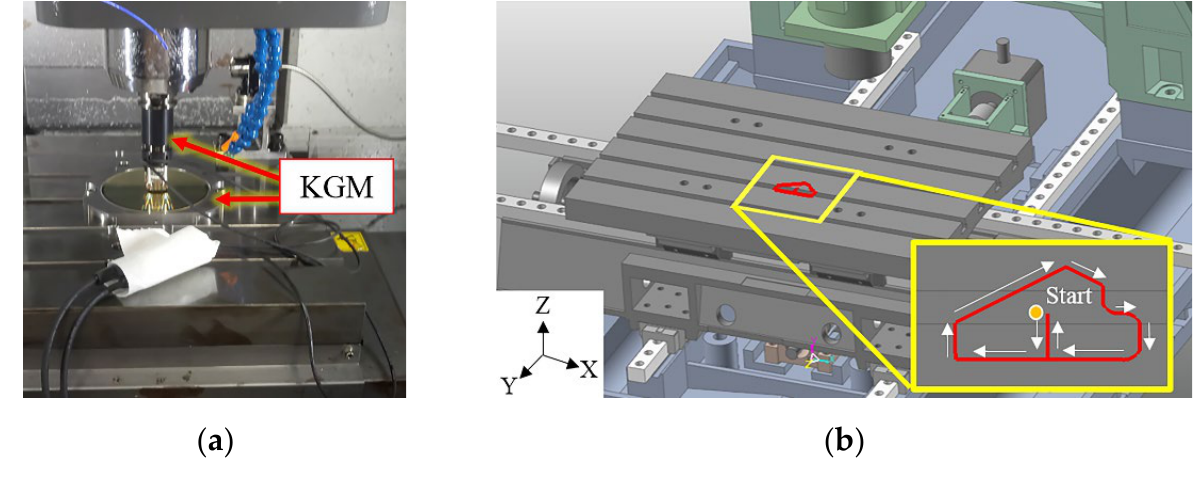
Figure 17. Motion trajectory: ( a ) KGM cross grid mounted on the machining center; ( b ) simulation.